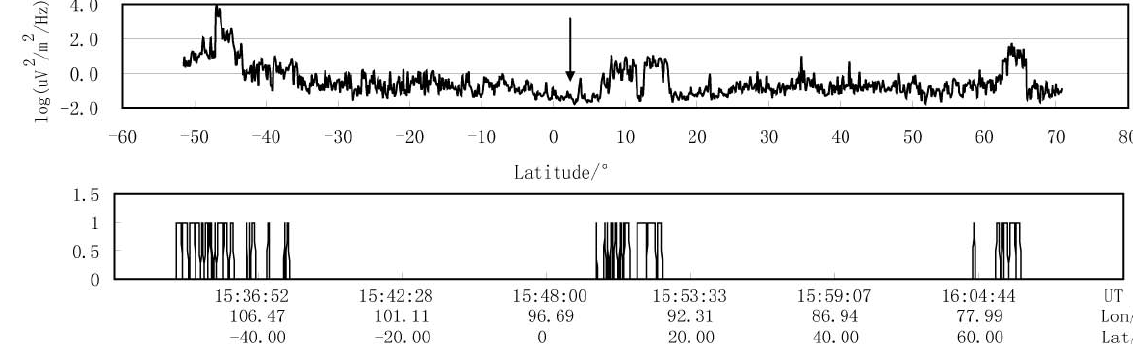
Fig. 2. Ionospheric perturbations in electric field along the orbit